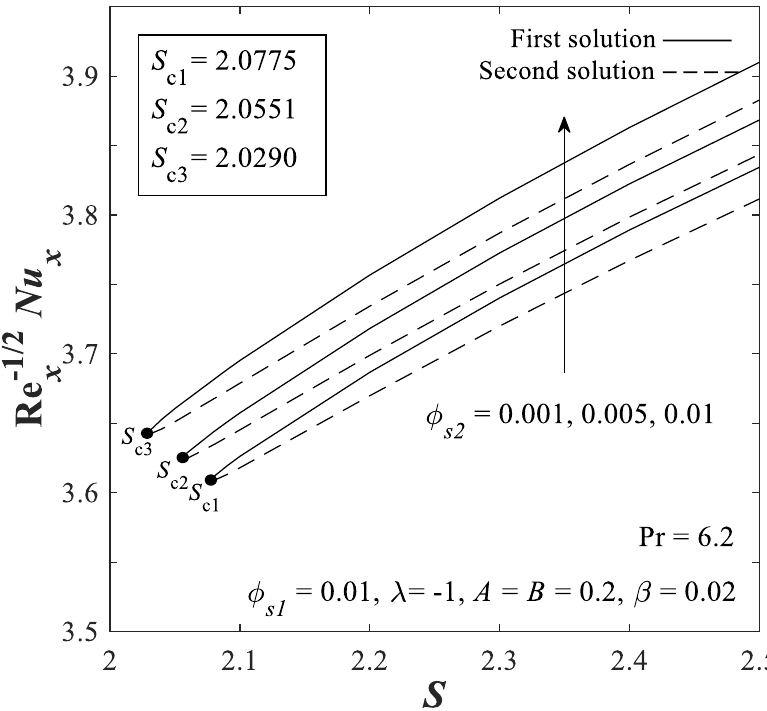
Figure 9. Plot of Re − 1/2 x Nu x with S for varied φ s 2 . Figure 9. Plot of  1/2 Re